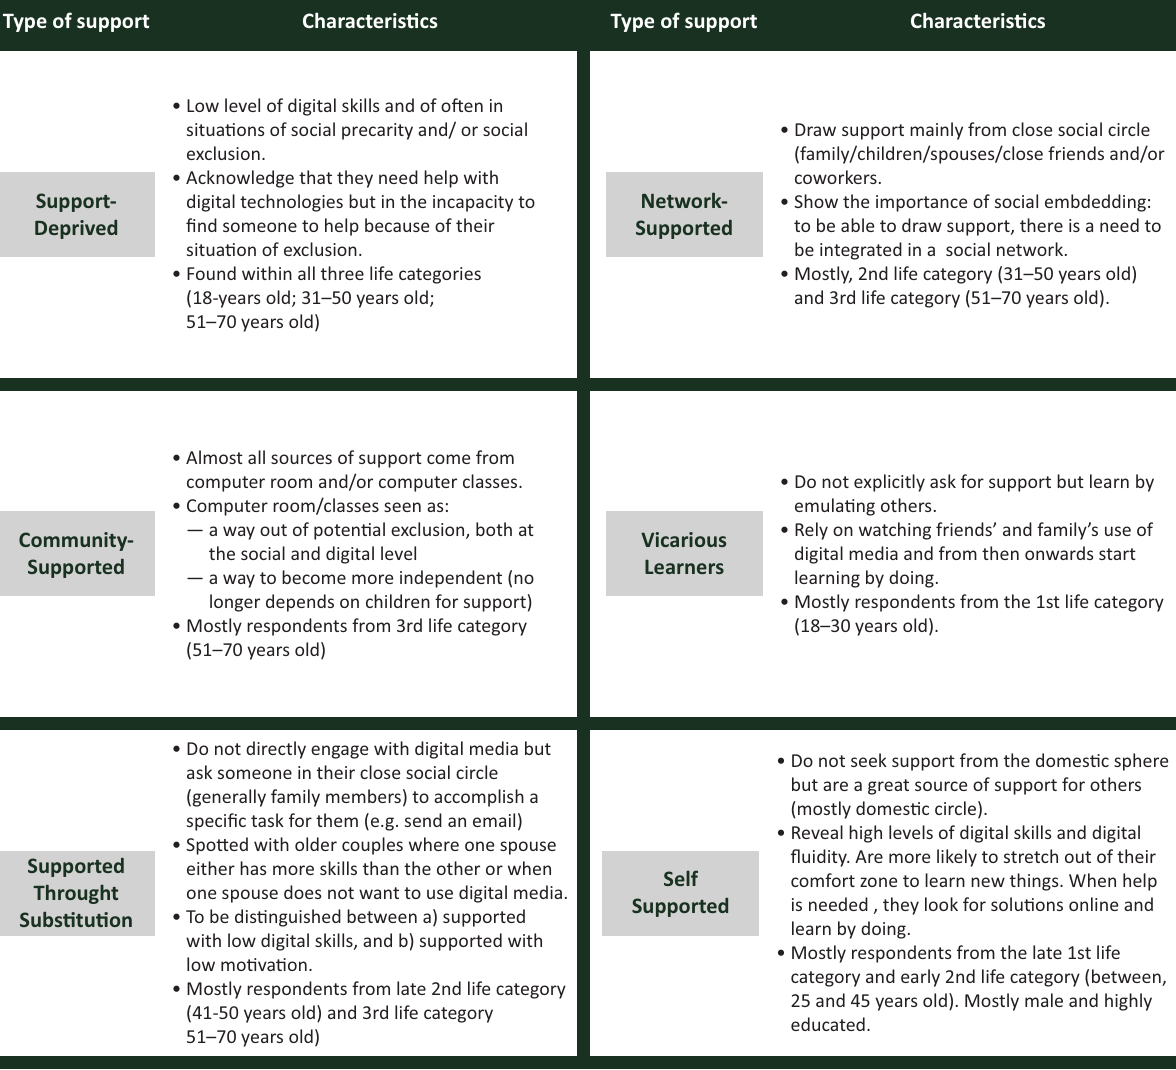
Figure 1. Patterns of social